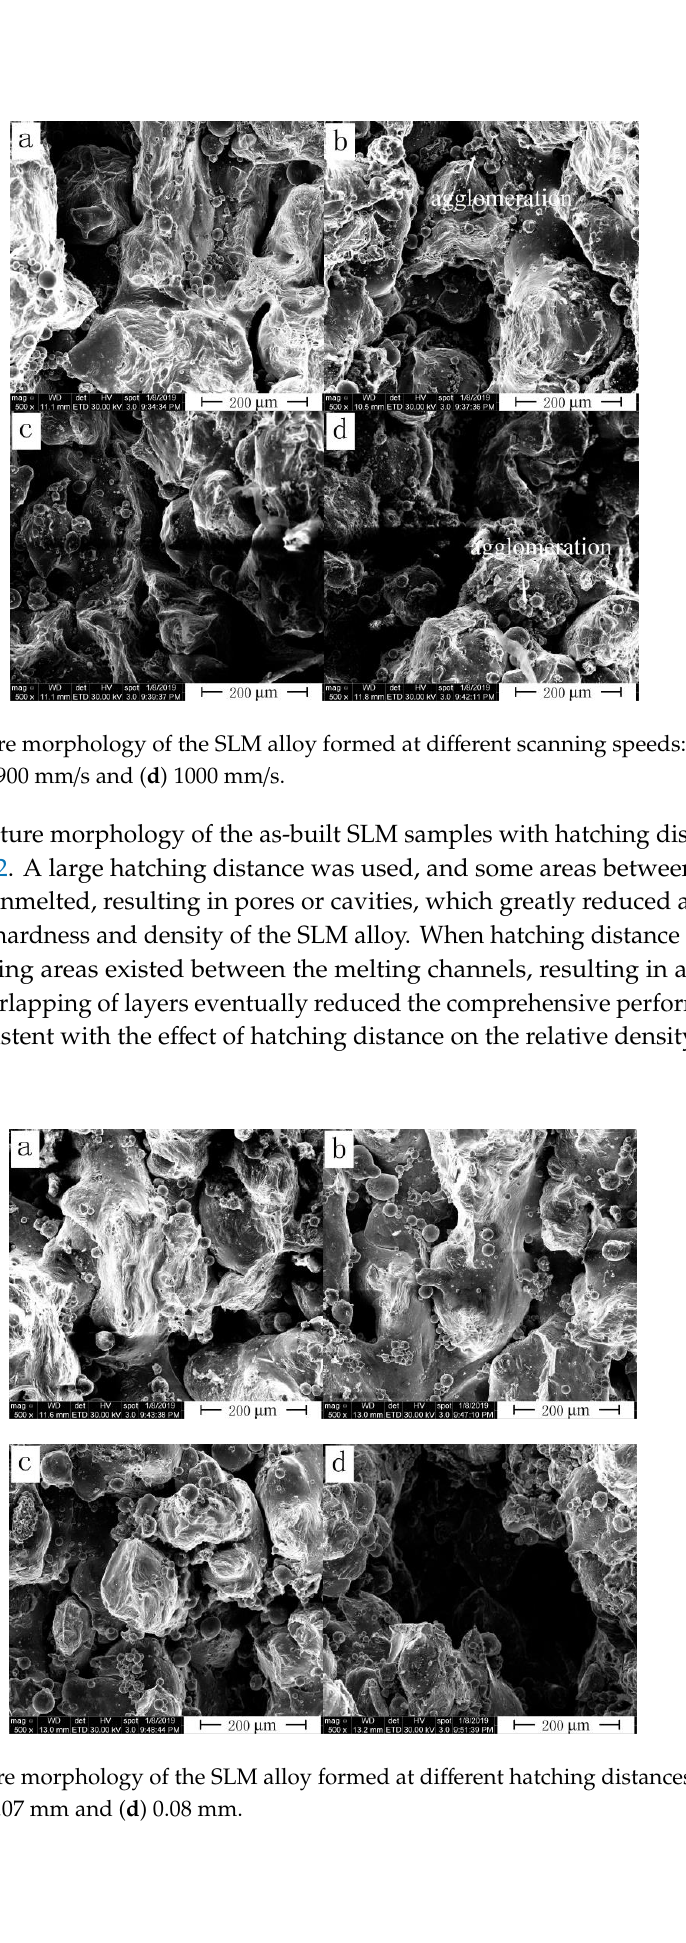
Figure 12. Fracture morphology of the SLM alloy formed at different hatching distances: ( a ) 0.05 mm, ( b ) 0.06 mm, ( c ) 0.07 mm and ( d ) 0.08 mm. ( b ) 0.06 mm, ( c ) 0.07 mm and ( d ) 0.08